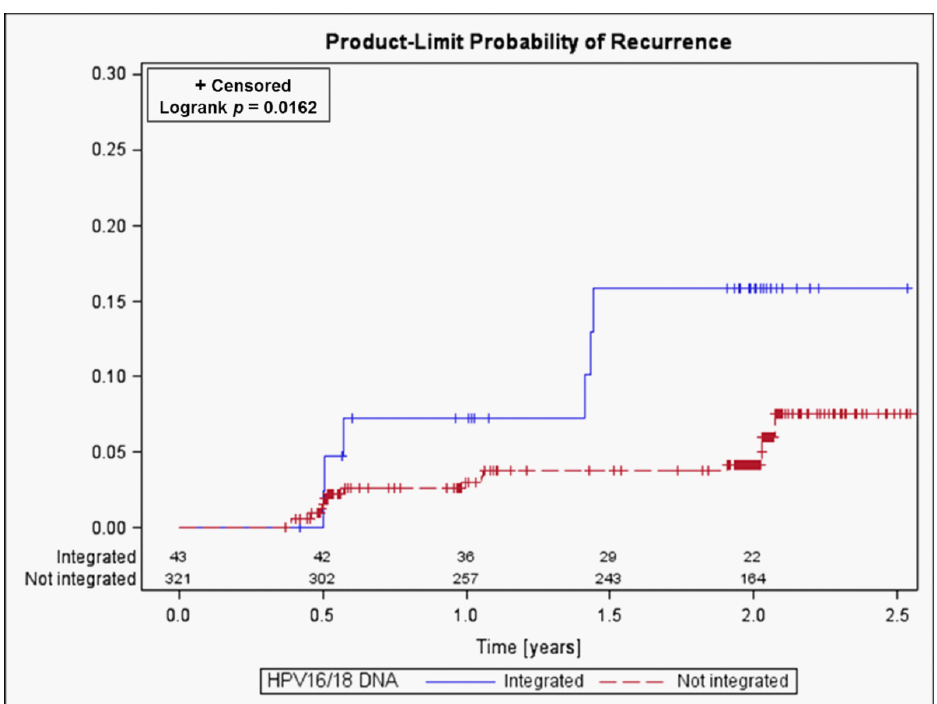
Figure 3. Cumulative probability of disease recurrence according to HPV16/18 DNA integration status.